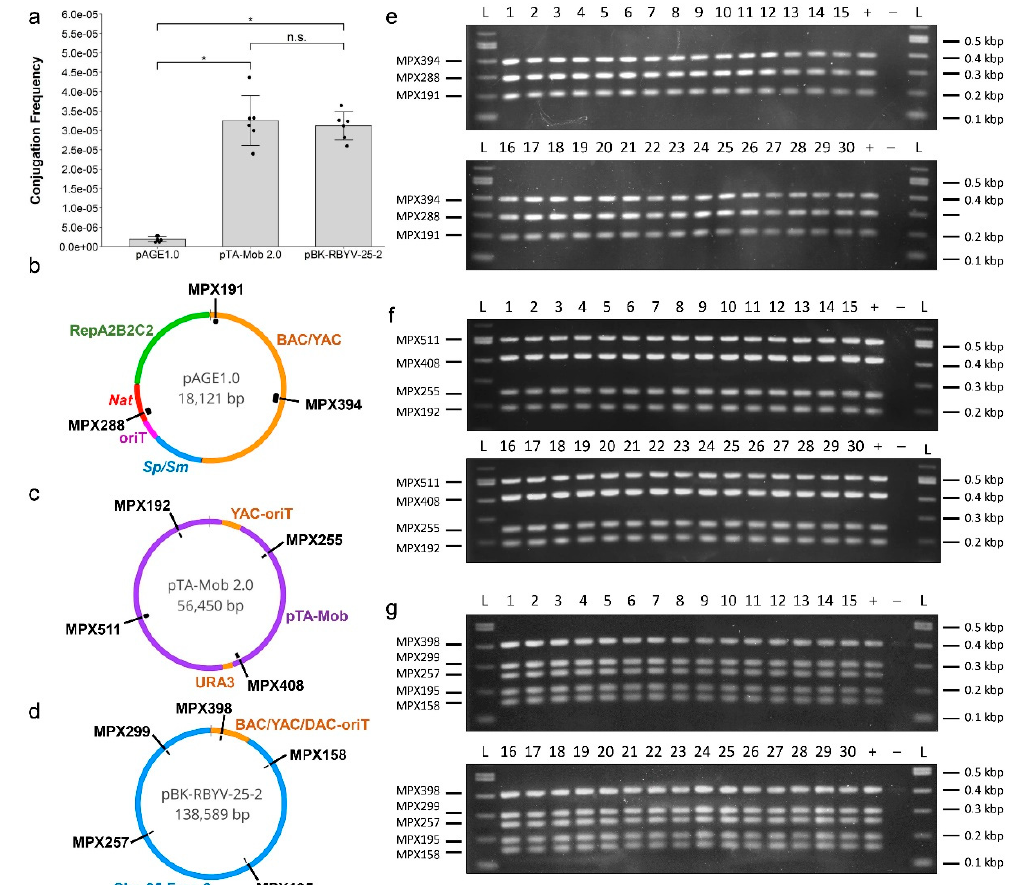
Figure 4. Conjugal transfer of plasmids increasing in size. ( a ) Conjugation frequency from donor E. coli containing either pTA-Mob 2.0 alone or pTA-Mob with either pAGE1.0 or pBK-RBYV-25-2 to recipient S. cerevisiae. *: indicates significant difference in conjugation frequency as determined by